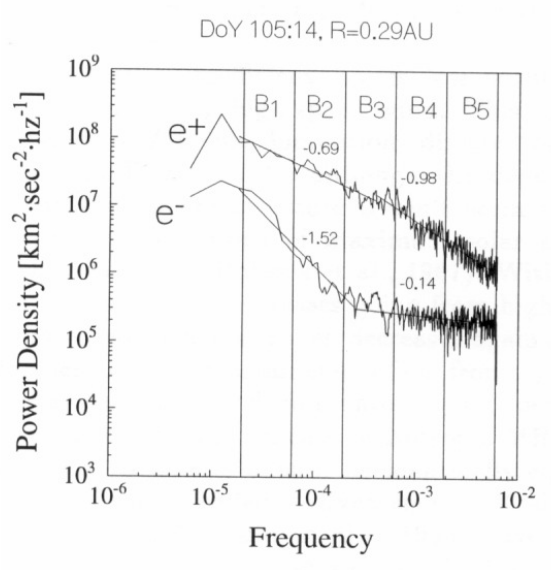
Figure 49: Power density spectra for e + and e – during a high velocity stream observed at 0.3 AU. Best fit lines for different frequency intervals and related spectral indices are also shown. Vertical lines fix the limits of five different frequency intervals analyzed by Bruno et al. (1996). Image reproduced by permission, copyright by